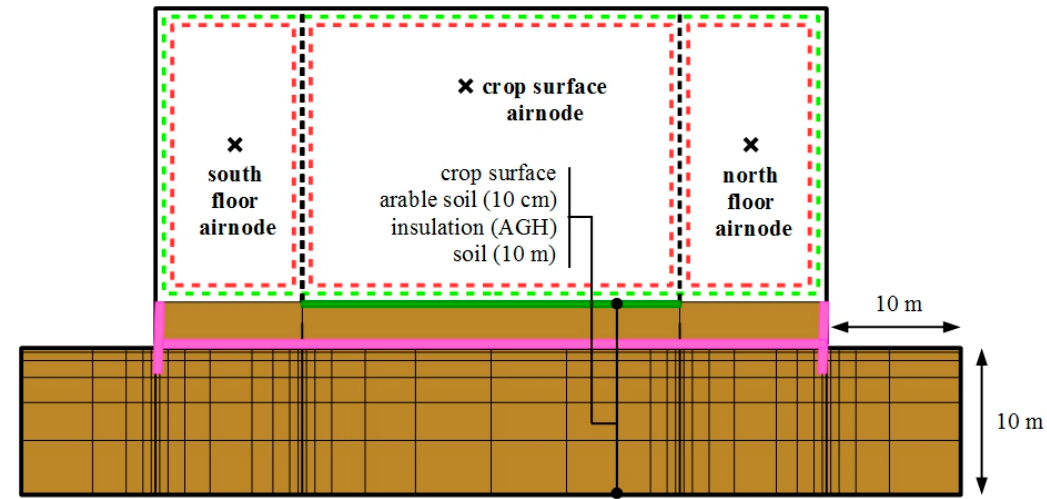
Figure 4. Same greenhouse model as Figure 3 but with a floor consisting of unfinished soil.